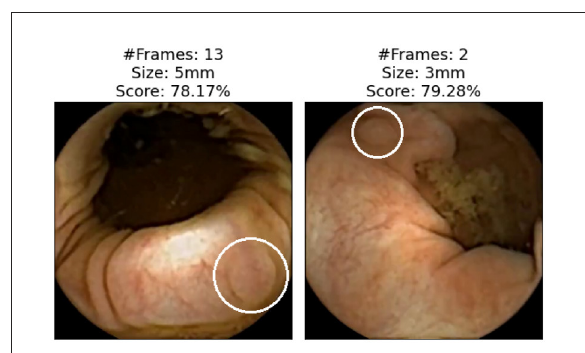
FIGURE6 Images that all experts have reviewed and found not to be polyps. Polyps are circled in